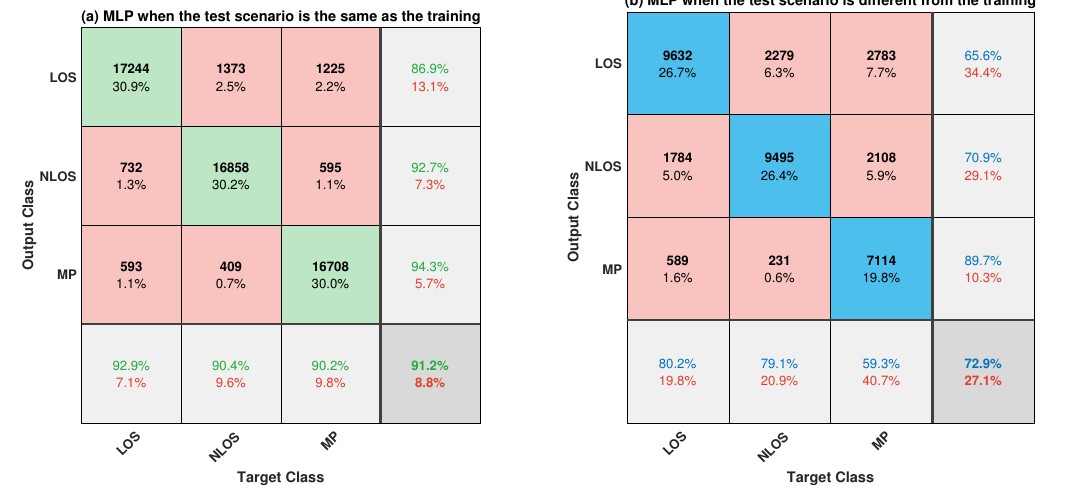
Figure 10. Comparison of the multi-class classification results for the MLP classifier using confusion matrices in two scenarios: ( a ) the test dataset obtained from the same conditions as the training phase; ( b ) the test dataset collected in a different condition from the training. In the evaluation, three fully-connected hidden layers with 100 neurons in each layer were used for the MLP classifier.